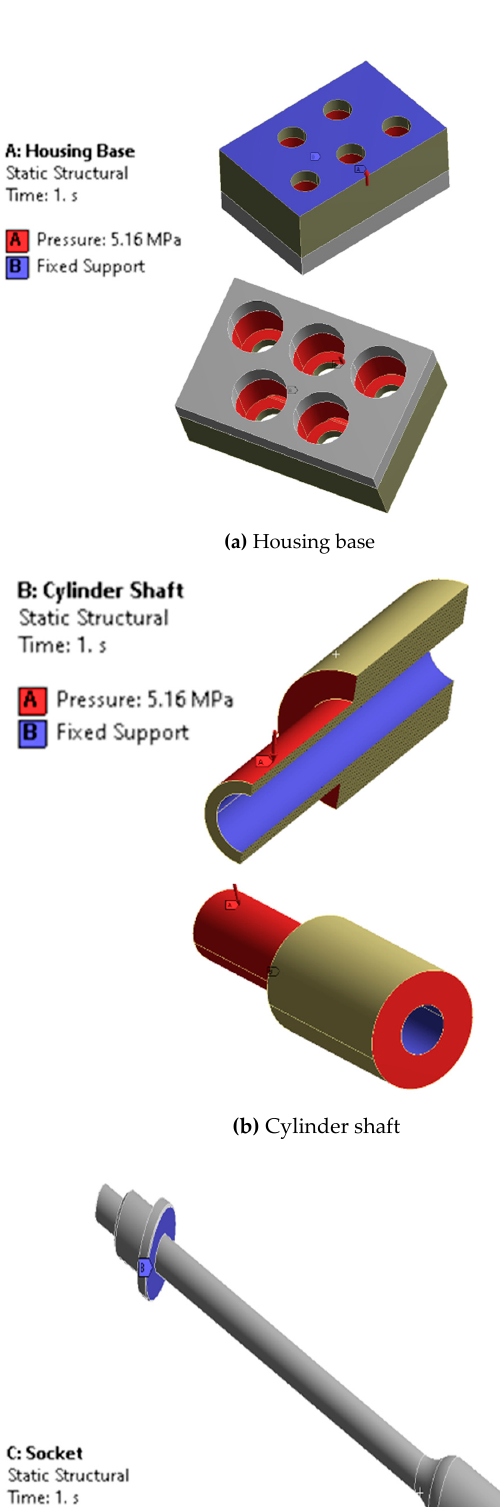
Figure 5. Meshing of the important components.